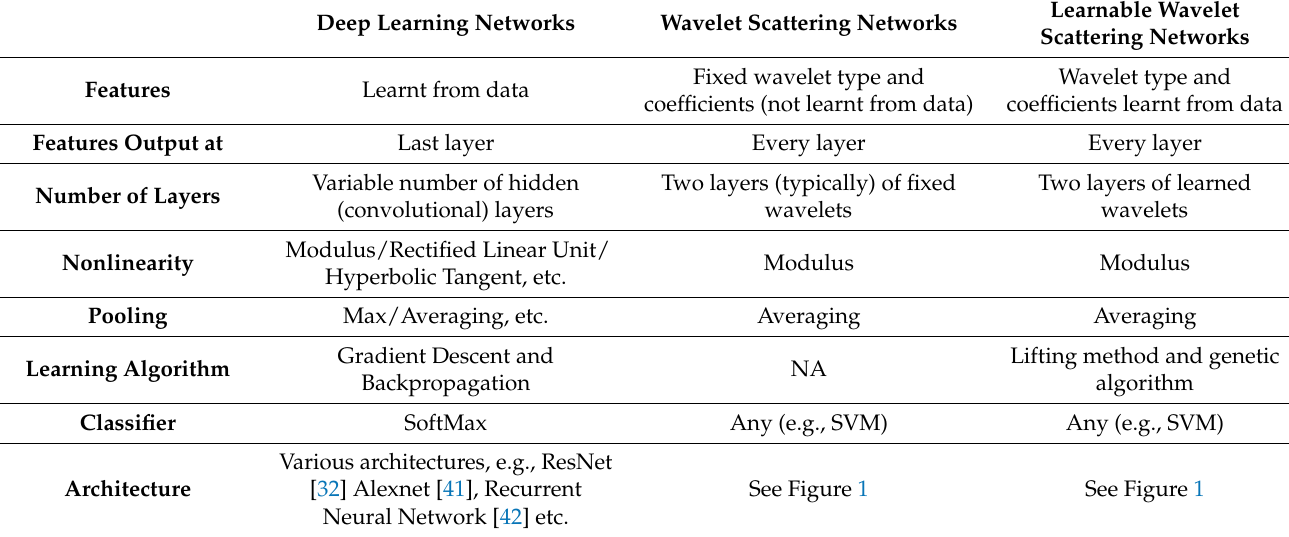
Table 1. Differences between networks.